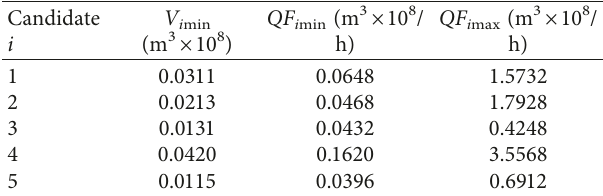
Table 4: Minimum storage and limitation of water flows of hy- dropower station candidates.